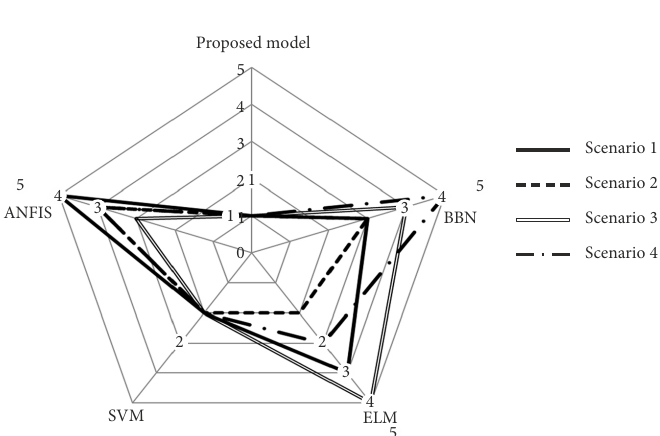
Figure 4. The results (ACC)